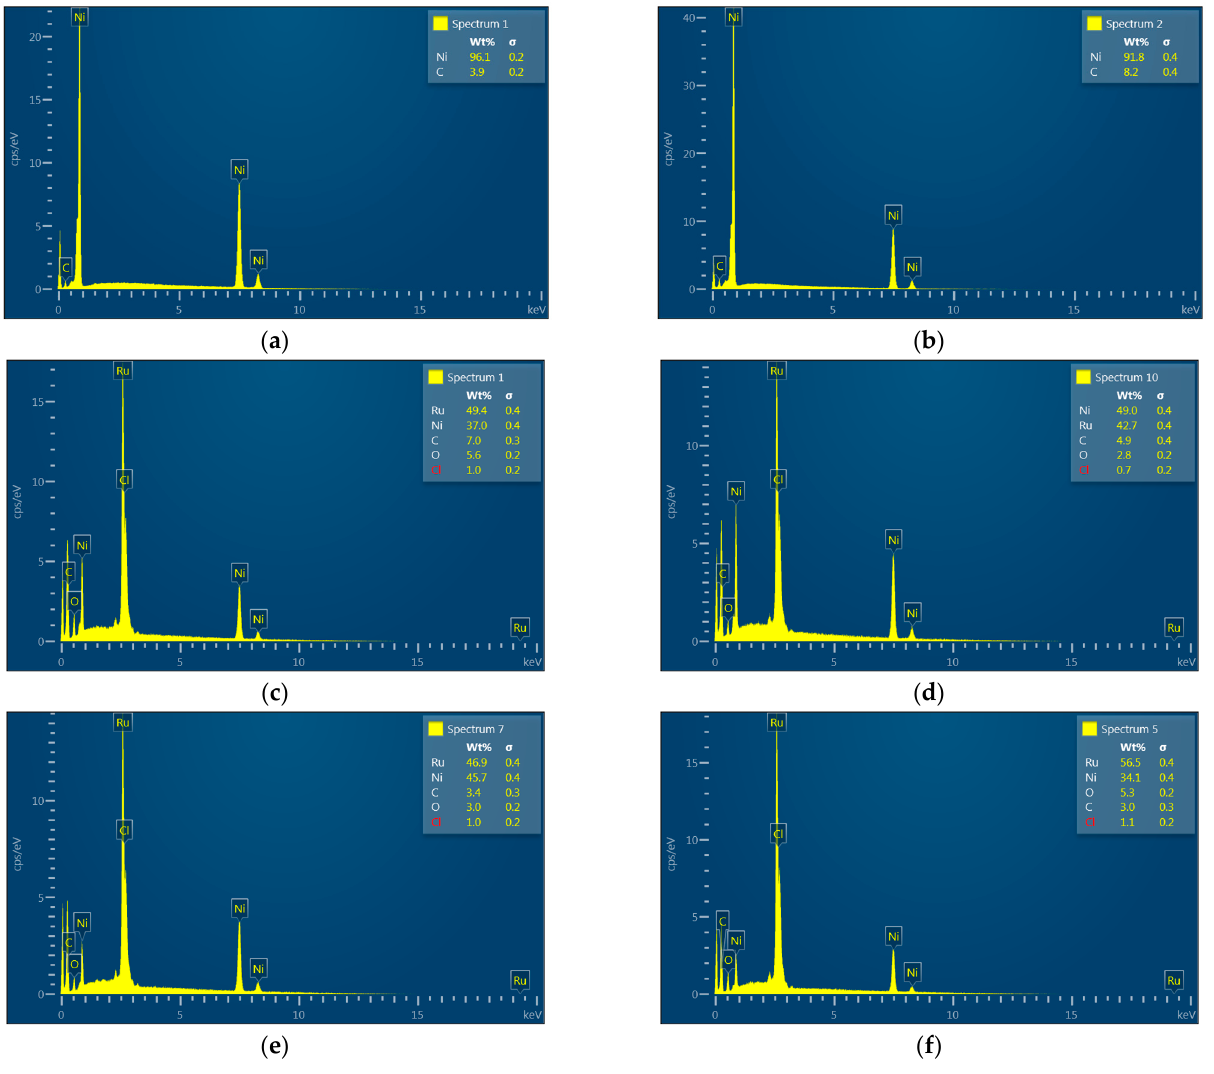
Figure 4. EDS spectra of ( a ) pristine NF, ( b ) NF*, ( c ) Ru/NF*, ( d ) Ru/NF*-A, ( e ) Ru/NF*-AH, and ( f ) Ru/NF*-AO.